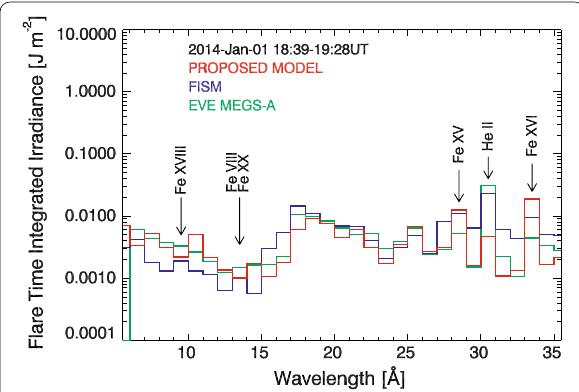
Fig. 8 Example of EUV time-integrated spectra during the flare. The EUV time-integrated spectra during the flare for the M9.9-class flare on January 1, 2014. The solid red, blue, and green lines indicate the calculated spectra of the proposed model, FISM, and observed spectra by SDO/EVE MEGS-A, respectively. The wavelength resolution is 10 Å. The arrows indicate the EUV lines focused on in this